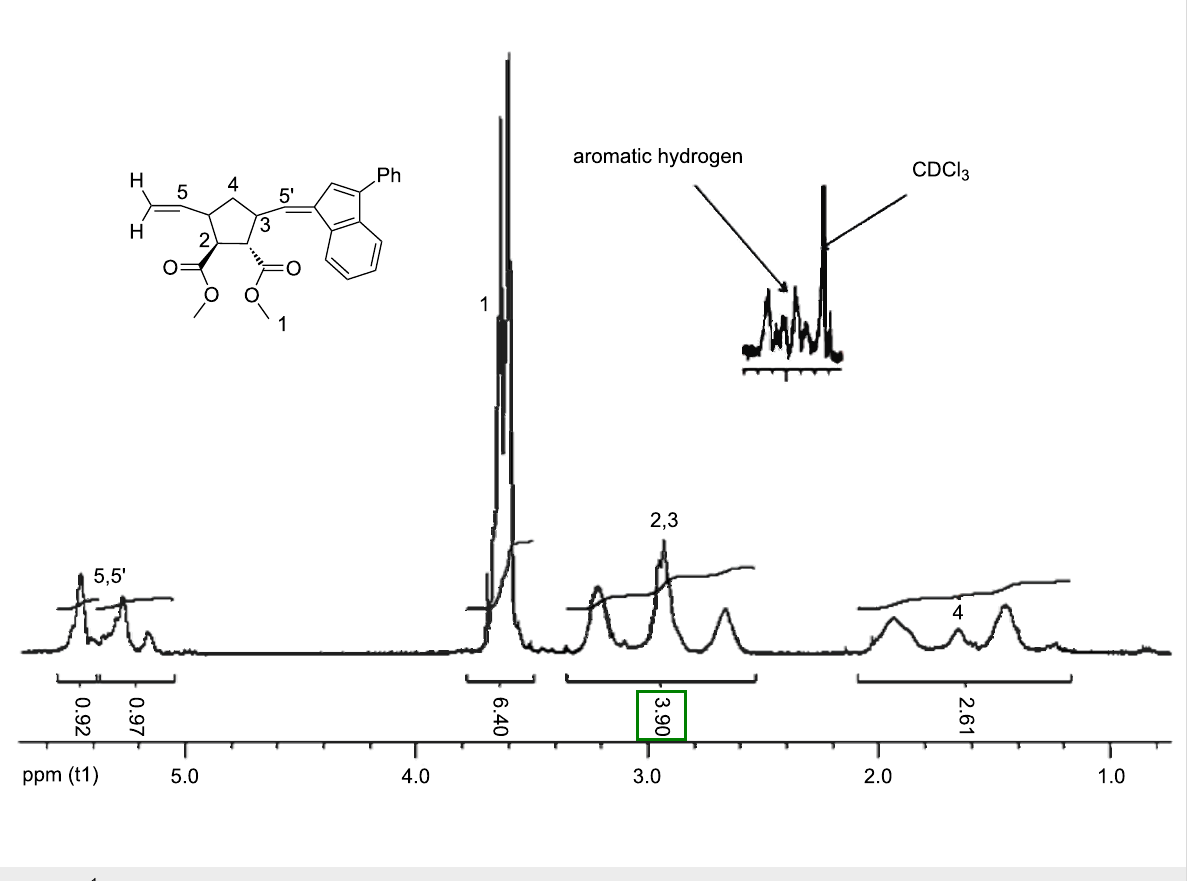
Figure 1: 1 H NMR spectrum of the homopolymer A 50 synthesized with the catalyst U3 .